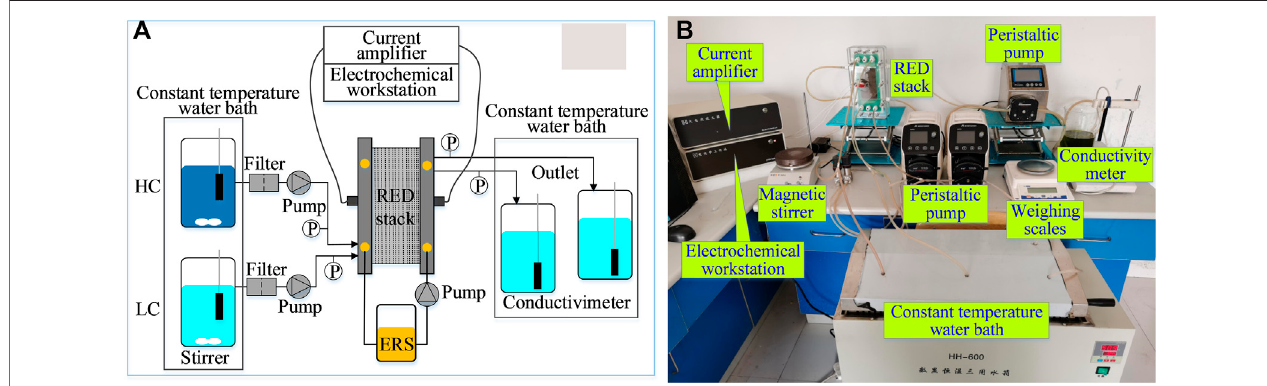
FIGURE 1 | Test system of the RED stack experiment.